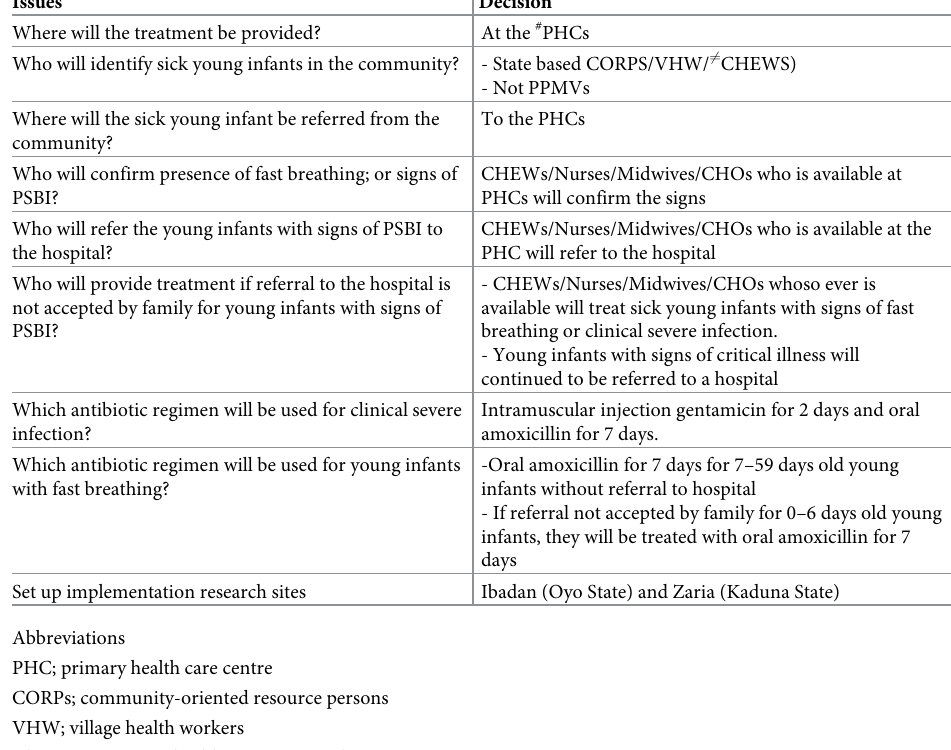
Table 1. Issues and decisions made during the national policy dialogue for management of PSBI in young infants 0–59 months of age when referral is not